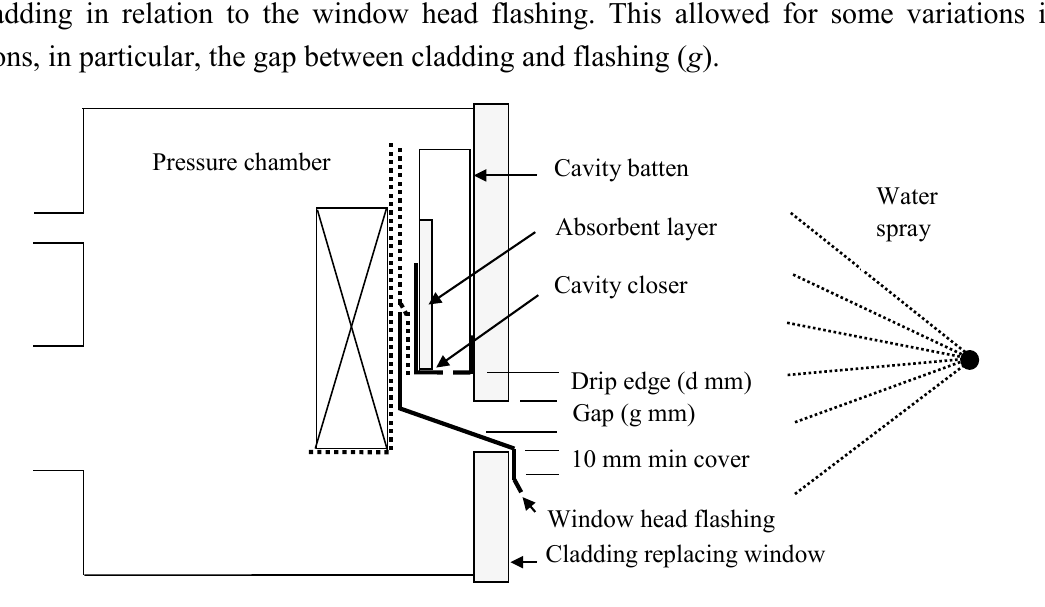
Figure 9. Experimental window head joint with cavity closer and variable joint